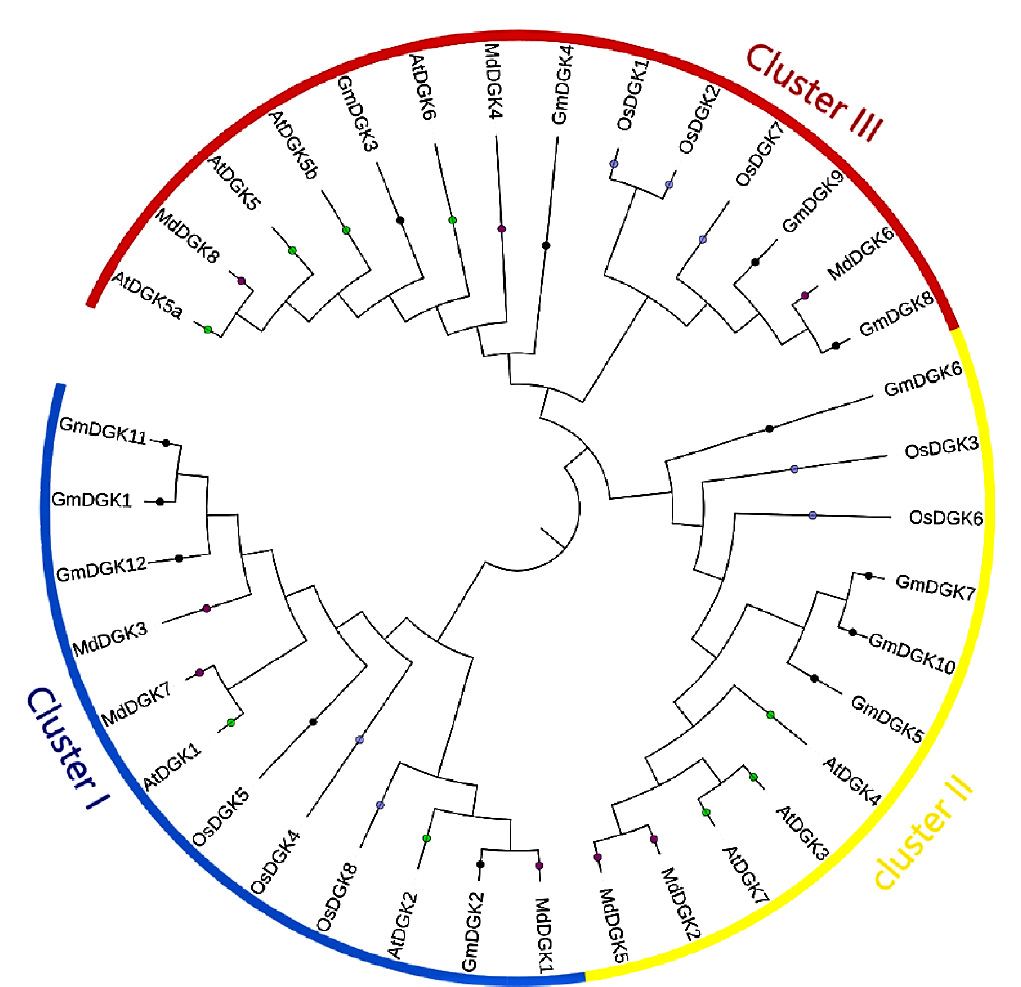
Figure 1. Phylogenetic analyses of diacylglycerol kinase (DGK) genes in four plant models: Glycine max (Gm), Arabidopsis thaliana (At), Oryza sativa (Os), and Malus domestica .